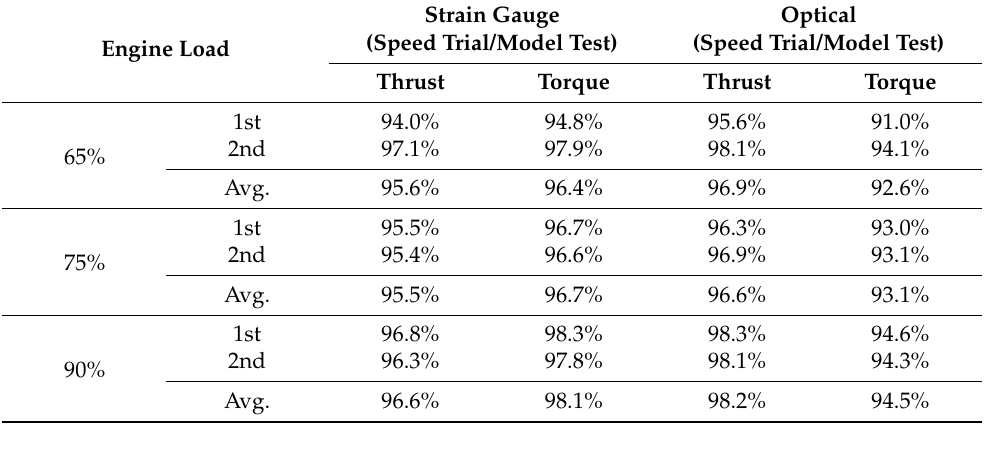
Table 3. Difference ratio between speed trial measurement and prediction results based on model test of the second vessel.